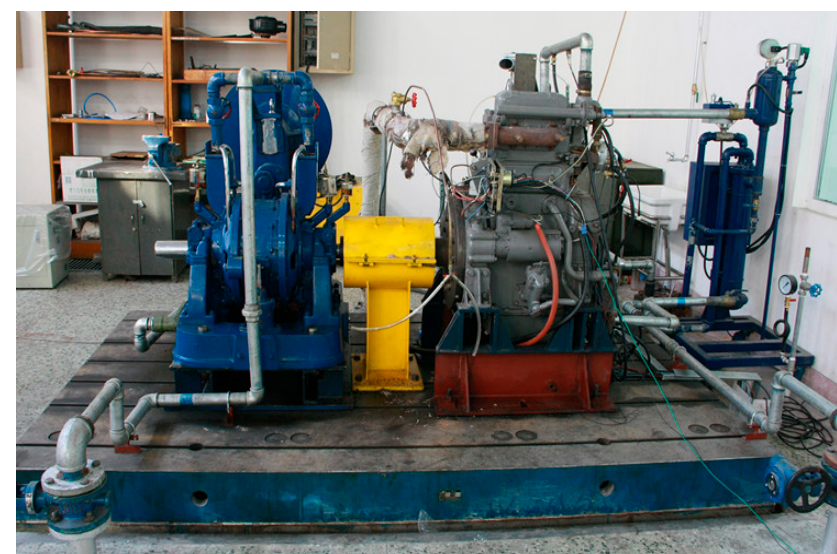
Figure 6. The transformed 2135 natural gas engine test bed. Table 2. Natural gas composition used in engine